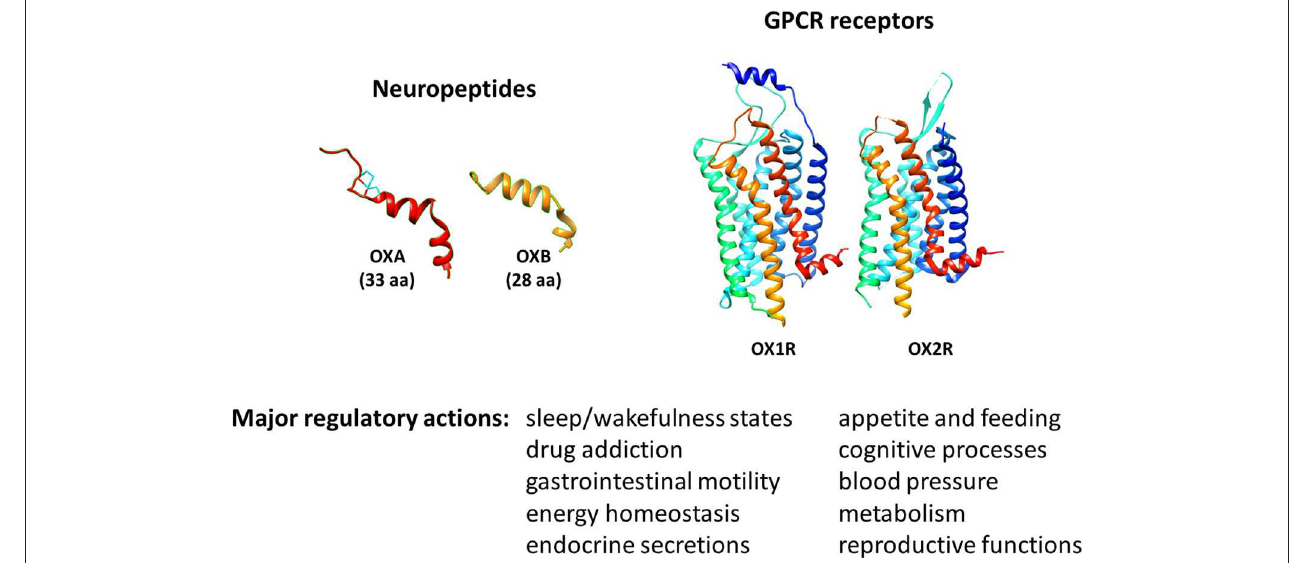
FIGURE 1 | Molecular 3D representation and biological roles of orexins/OXRs